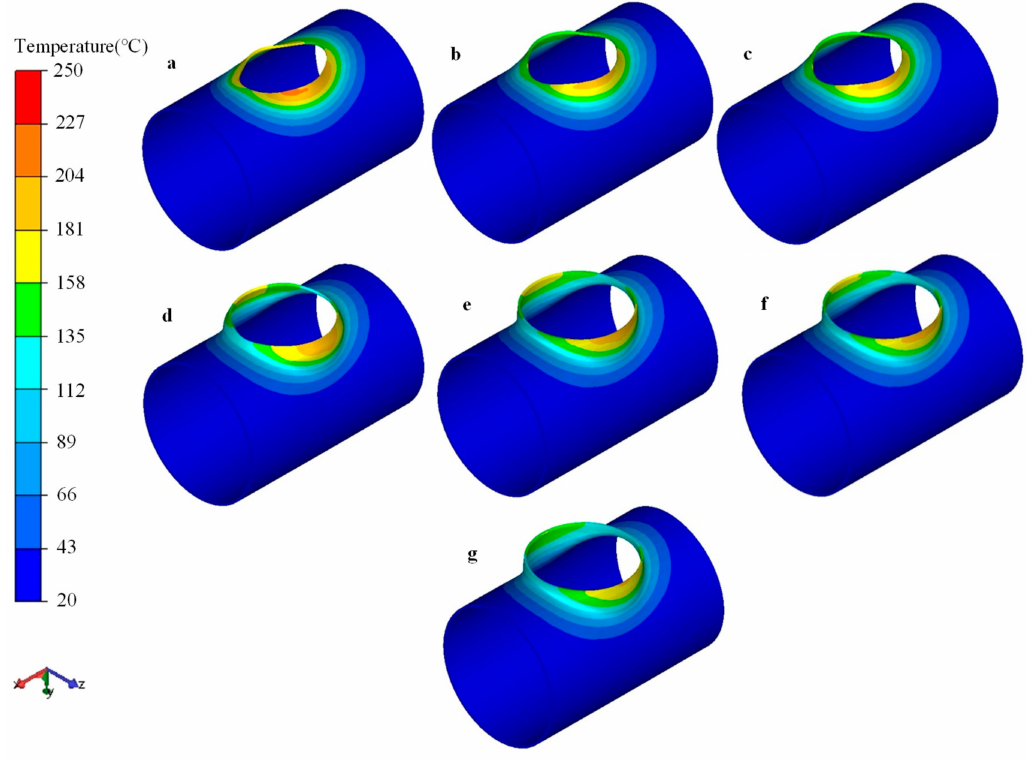
Figure 18. Distribution of temperature at chosen stages during flanging process, strokes of upper die were ( a ) 100 mm, ( b ) 200 mm, ( c ) 315 mm, ( d ) 350 mm, ( e ) 430 mm, ( f ) 450 mm, ( g ) 500